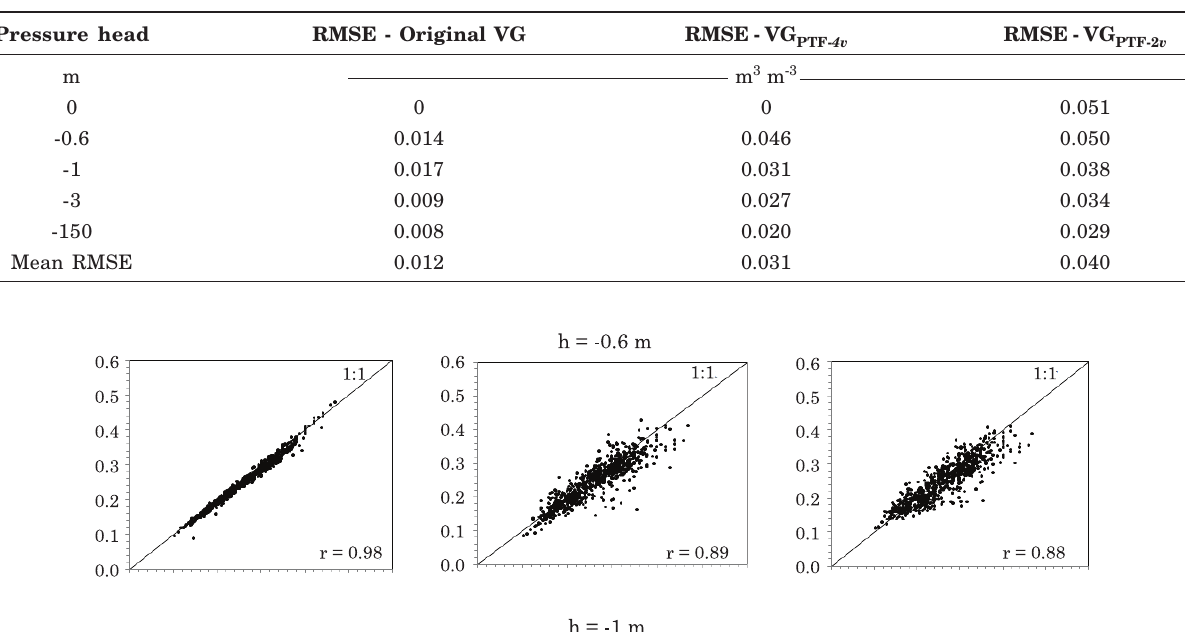
Table 7. Root mean square error (RMSE) of different prediction approaches for water content at specific pressure head values: original van Genuchten (VG) models and VG models derived from parameters estimated by PTFs (VGPTF-4v and VGPTF-2v, N = 673)